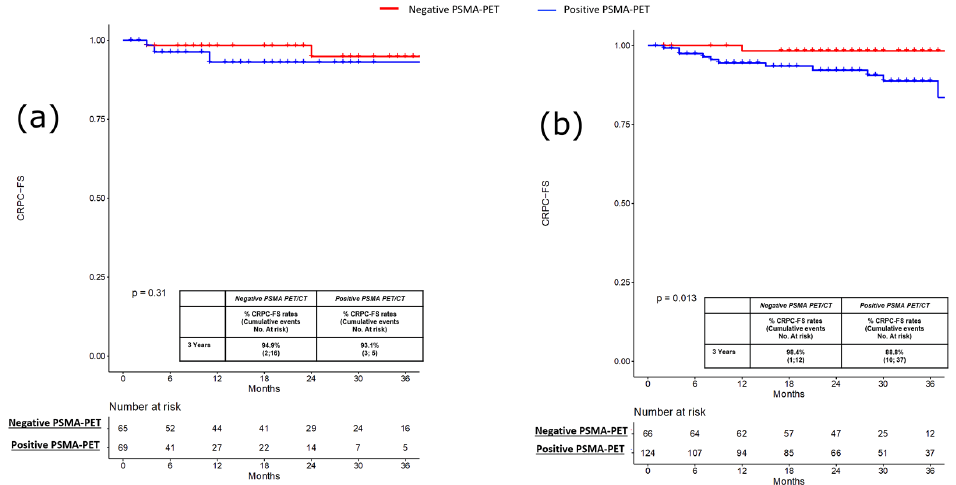
Figure 3. ( a ) Kaplan-Meier curve depicting Castration Resistant Prostate Cancer Free Survival (CRPC-FS) rates in the pre-salvage setting ( n = 134) according to PSMA-PET results (namely, positive vs. negative); ( b ) Kaplan-Meier curve depicting Castration Resistant Prostate Cancer Free Survival (CRPC-FS) rates in the post-salvage setting ( n = 190) according to PSMA-PET results (namely, positive vs. negative).